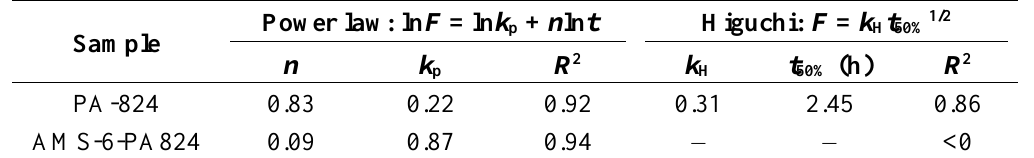
Table 2. Parameters of power law and Higuchi equations for the release curves of free and encapsulated PA-824 ( k : Kinetic constant; n : release exponent; R : coefficient of correlation, t 50% : time taken to release 50% of